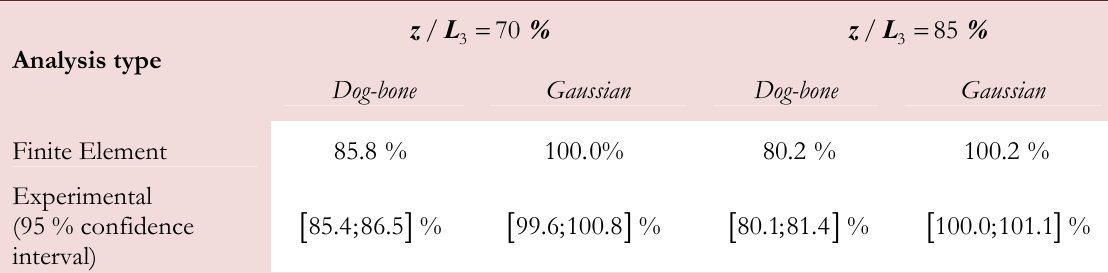
Table 1: Comparison between numerical and experimental results: values of the